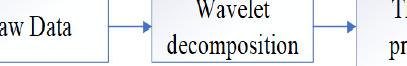
Figure 5. Wavelet denoising process.